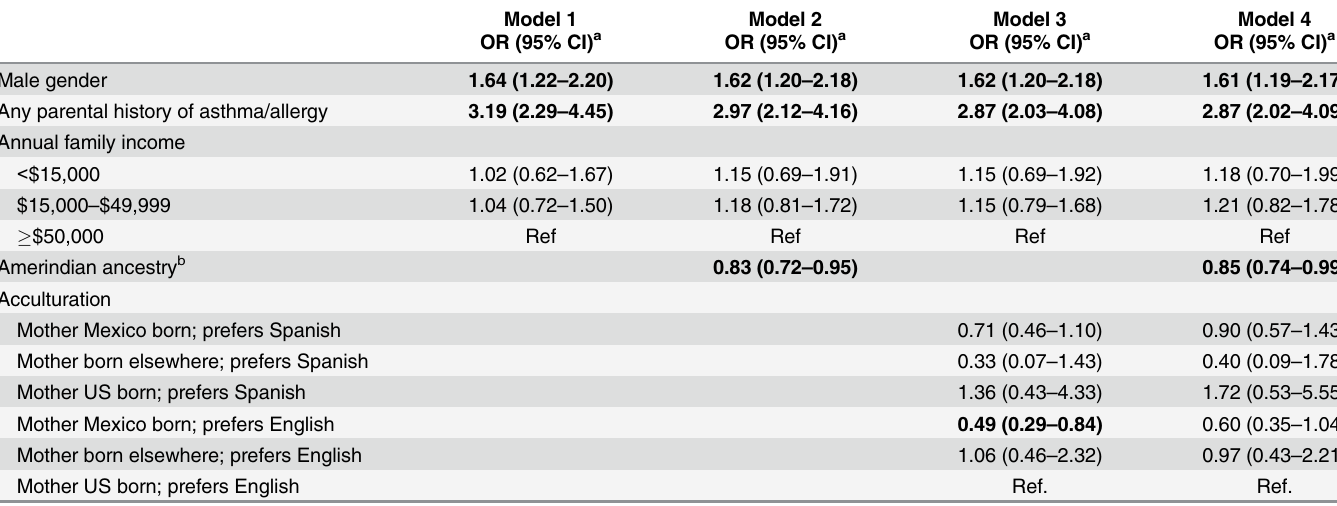
Table 5. Multivariate Association between Amerindian Genetic Ancestry and Asthma.